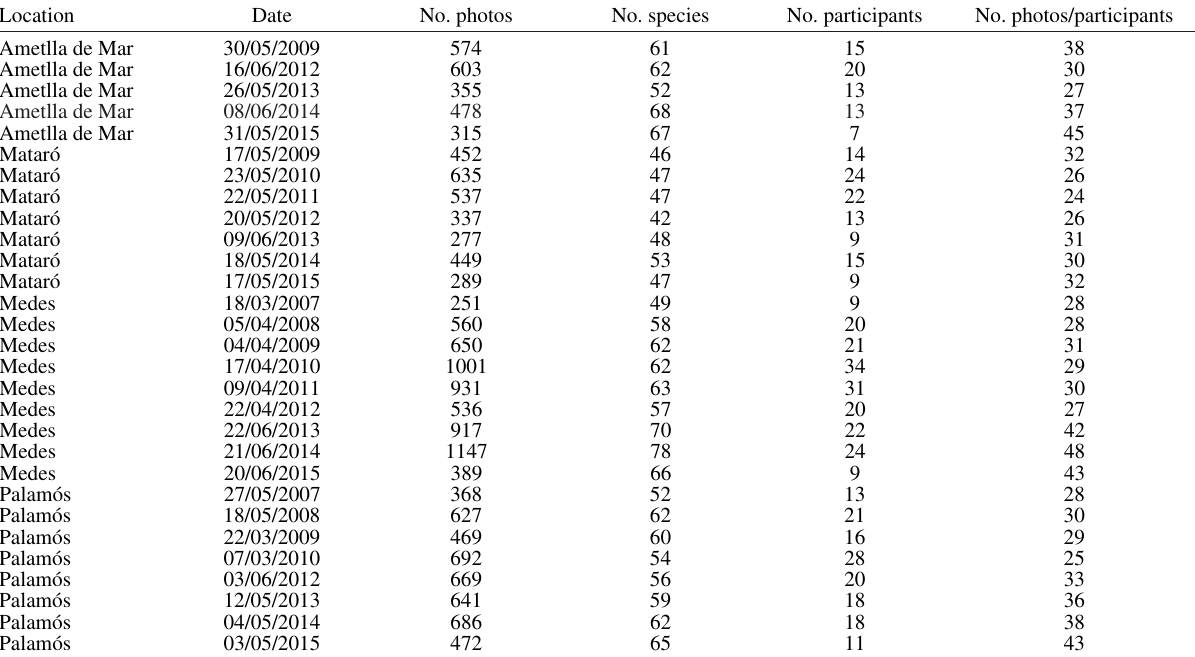
Table 1. – Descriptors of the free-diving fish photograph contests